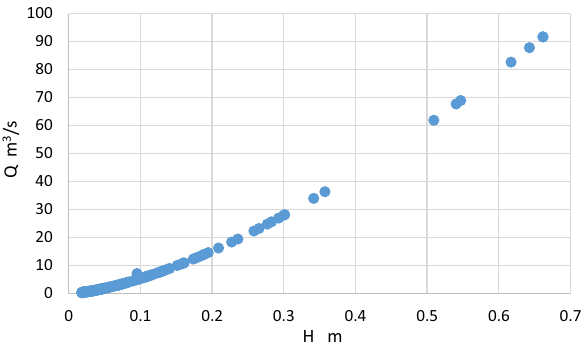
Fig. 7 The relation between head and discharge